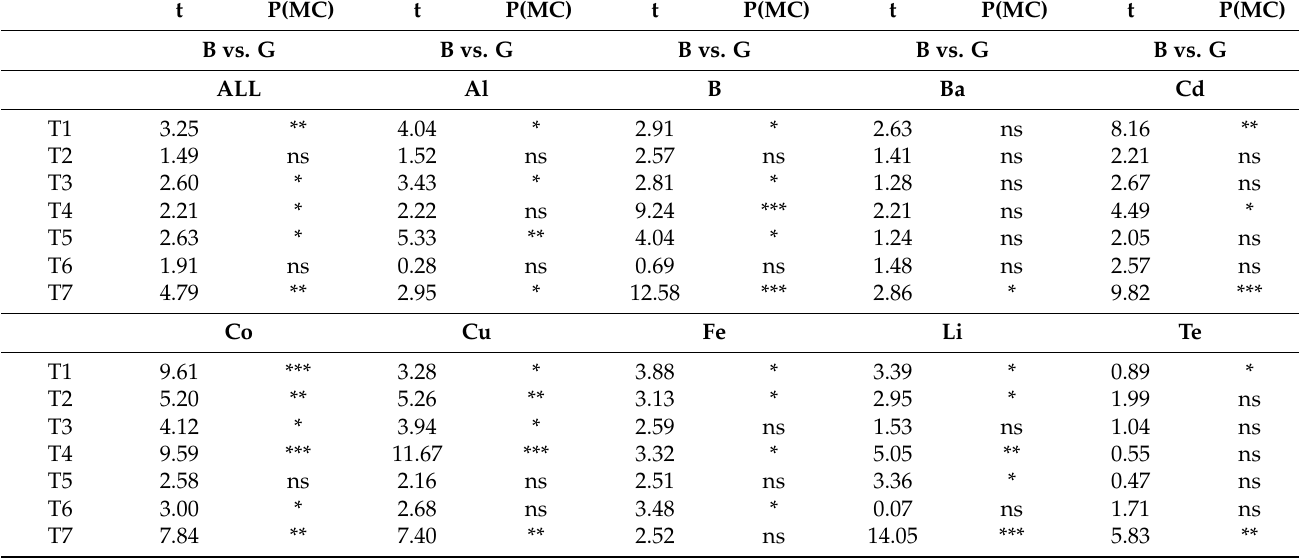
Table 3. Results of the pairwise tests contrasting element concentration composition and single elements between the umbrella (B) and gonads (G) of jellyfish within each sampling time. T = T value, P(MC) = probability level after Monte Carlo simulations. * = p < 0.05; ** = p < 0.01; *** = p < 0.001; ns = not